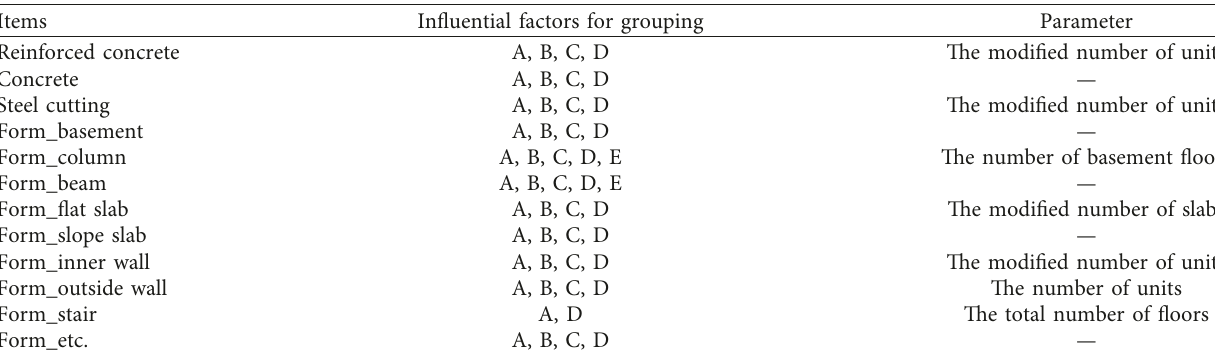
Figure 4: Regression analysis (e.g., reinforced concrete). Table 4: Influential factors and parameter of each